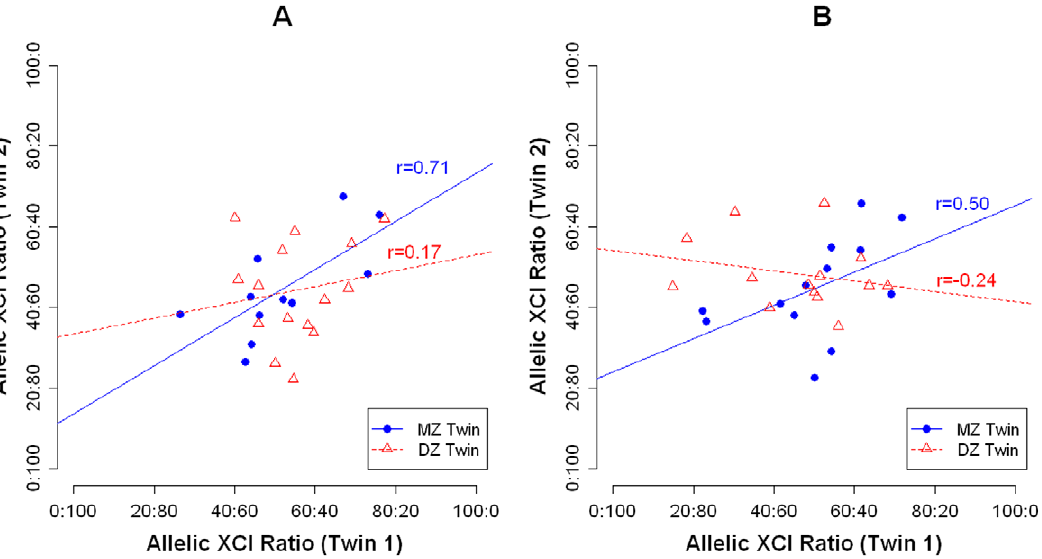
Figure 3. Allelic XCI ratios of MZ and DZ twin pairs at ages 5 and 10 years. ( A ) MZ and DZ twin correlations for XCI ratio at age 5. ( B ) MZ and DZ twin correlations for XCI ratio at age 10. XCI=X-Chromosome Inactivation ; MZ=Monozygotic ; DZ=Dizygotic .